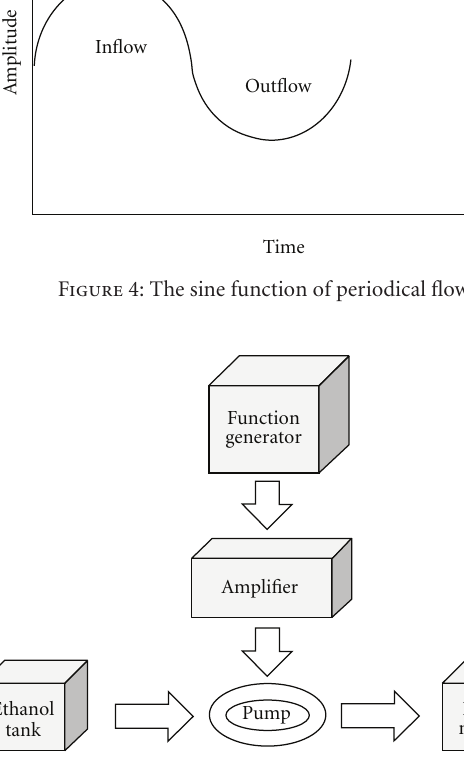
Figure 5: The flow chart of fuel injection system.